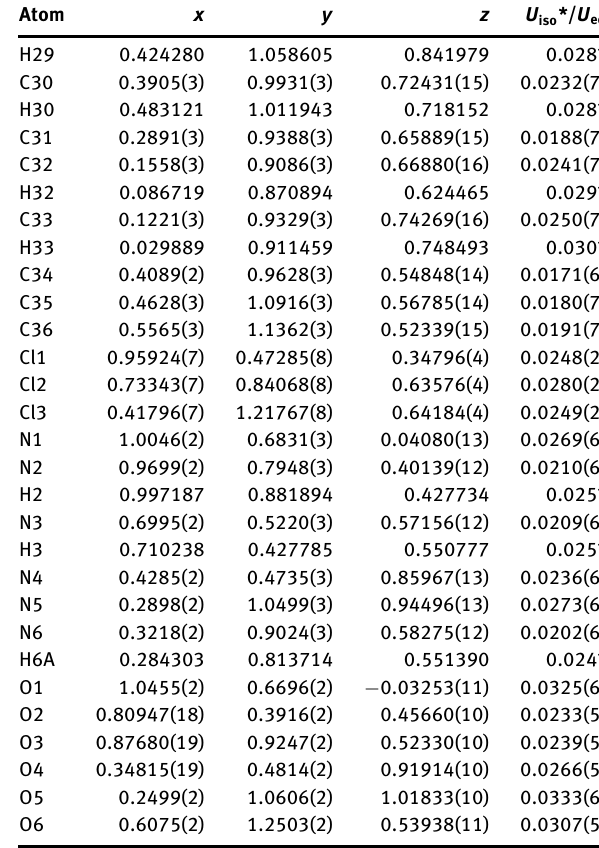
Table 2: Fractional atomic coordinates and isotropic or equivalent isotropic displacement parameters (Å 2